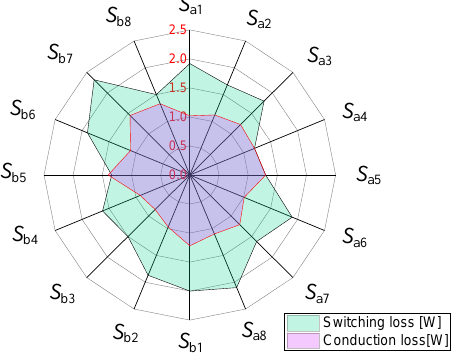
Figure 22. Comparison of IPF vs. load with conventional rectifier.